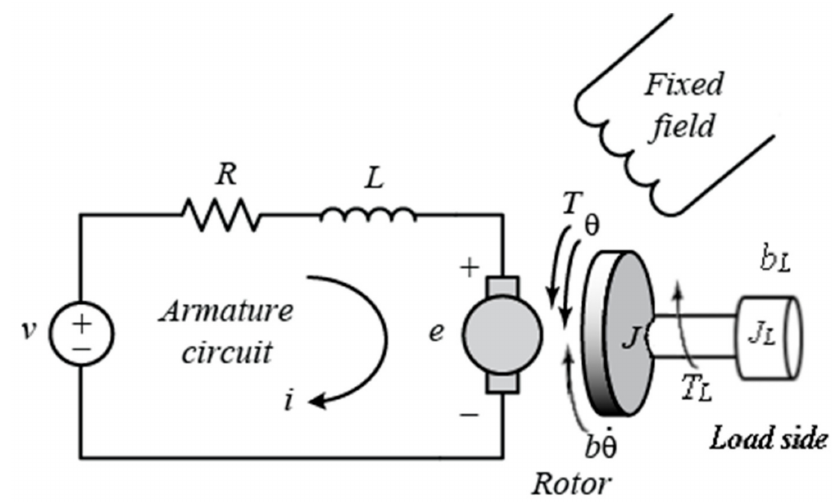
Figure 2. Physics-based schematic of a DC-driven universal